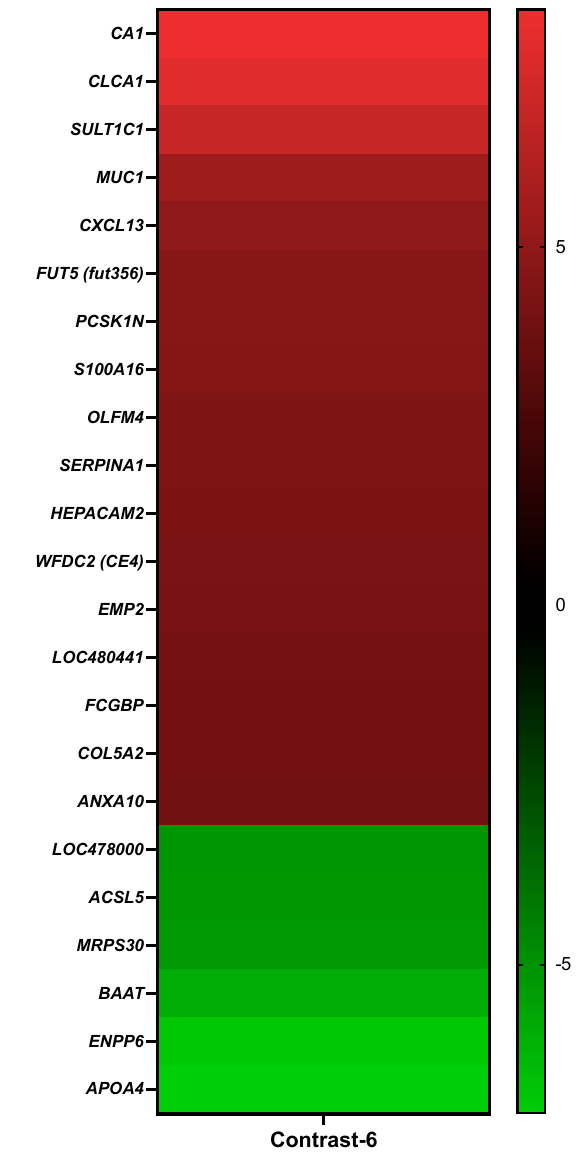
Figure 7. A heat map depicting the color-coded expression levels (log-ratio M values) of the top 17 upregulated and six downregulated DEGs in the LPS treated IBD colonoids vs. the LPS treated IBD enteroids (Contrast-6). The log-ratio M values represent the log(R/G) (log fold change) [44]. The detailed information on genes is presented in Table 9.